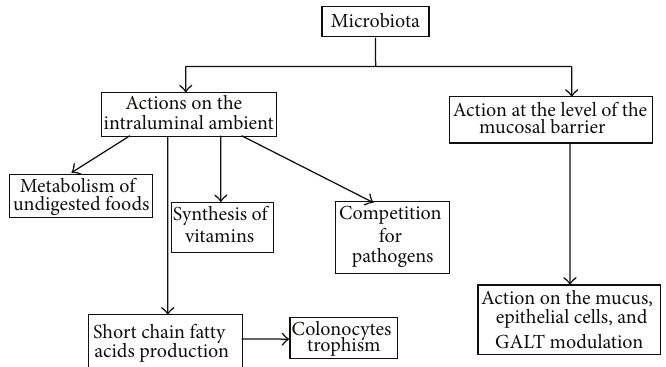
Figure 1: Action taken by microbiota in normal conditions.